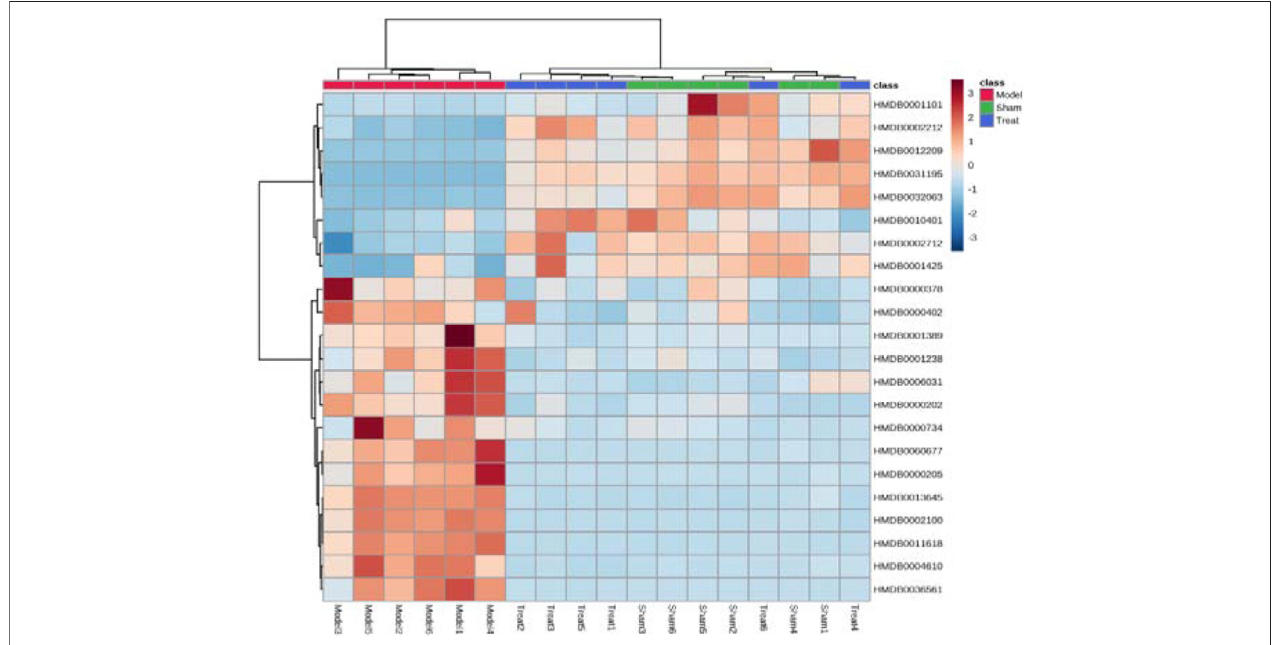
FIGURE8| Hierarchicalclusteranalysisheatmapofpotentialbiomarkersineachgroup.Horizontalistheclusteringofpotentialbiomarkers,verticalistheclustering of different groups of samples, red represents signi fi cantly up-regulated biomarkers, blue represents signi fi cantly down-regulated biomarkers, and the biomarkers clustered in the same cluster have similar expression patterns.